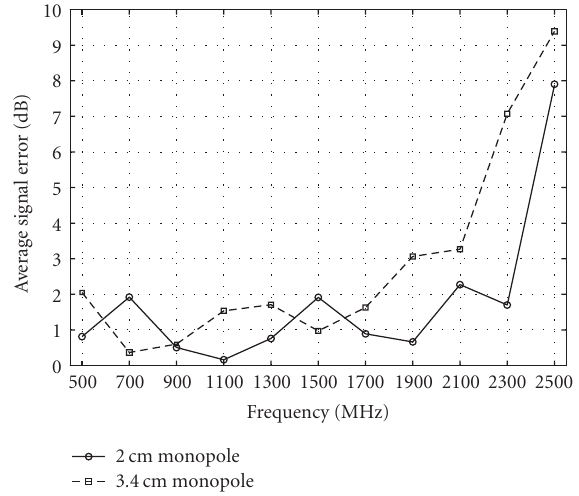
Figure 12: Plots of the average di ff erences in signal strengths (uti- lizing only values for receivers 7, 8, and 9) between the shallow (2.0cm) and deep (6.5cm) measurement cases as a function of fre- quency for the 3.4 and 2.0 cm antenna lengths in the 90% glycerin coupling